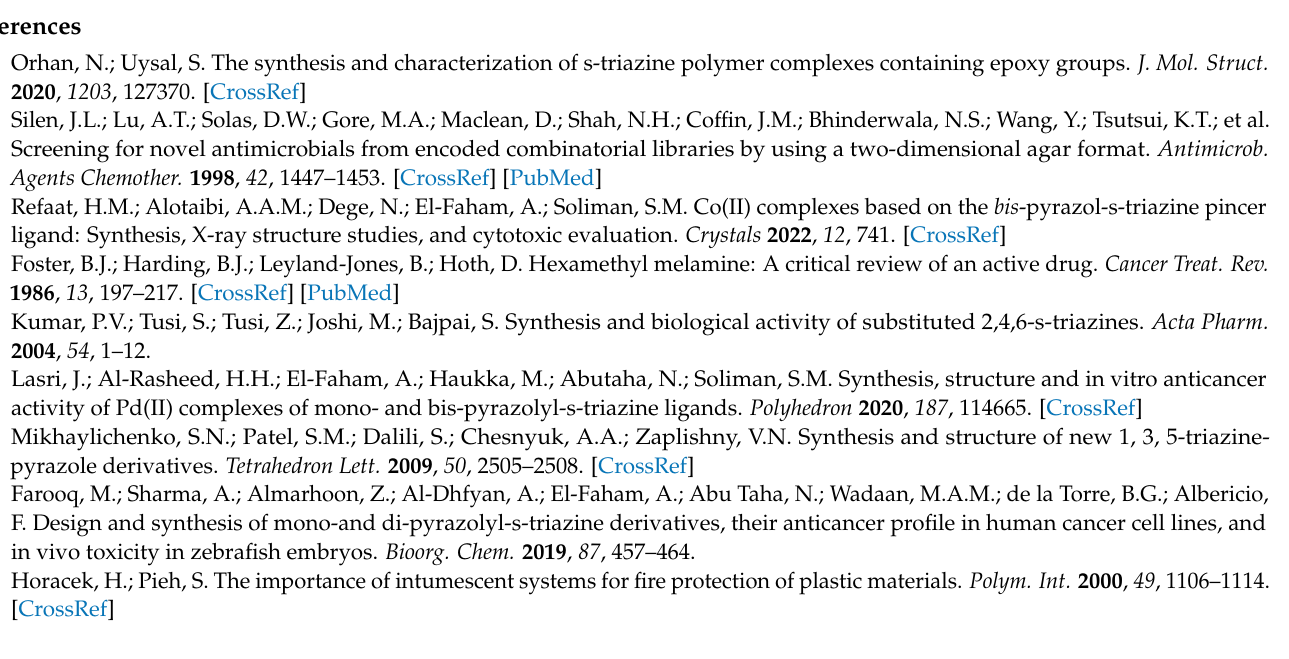
Figure S3: 1 H and 13 C NMR spectra of the ligand (BPT). Chemical shifts are reported in parts per million (ppm). Table S1: The cytotoxicity of the studied complex against the HepG-2 cell line; Table S2: The cytotoxicity of the studied complex against the A-549 cell